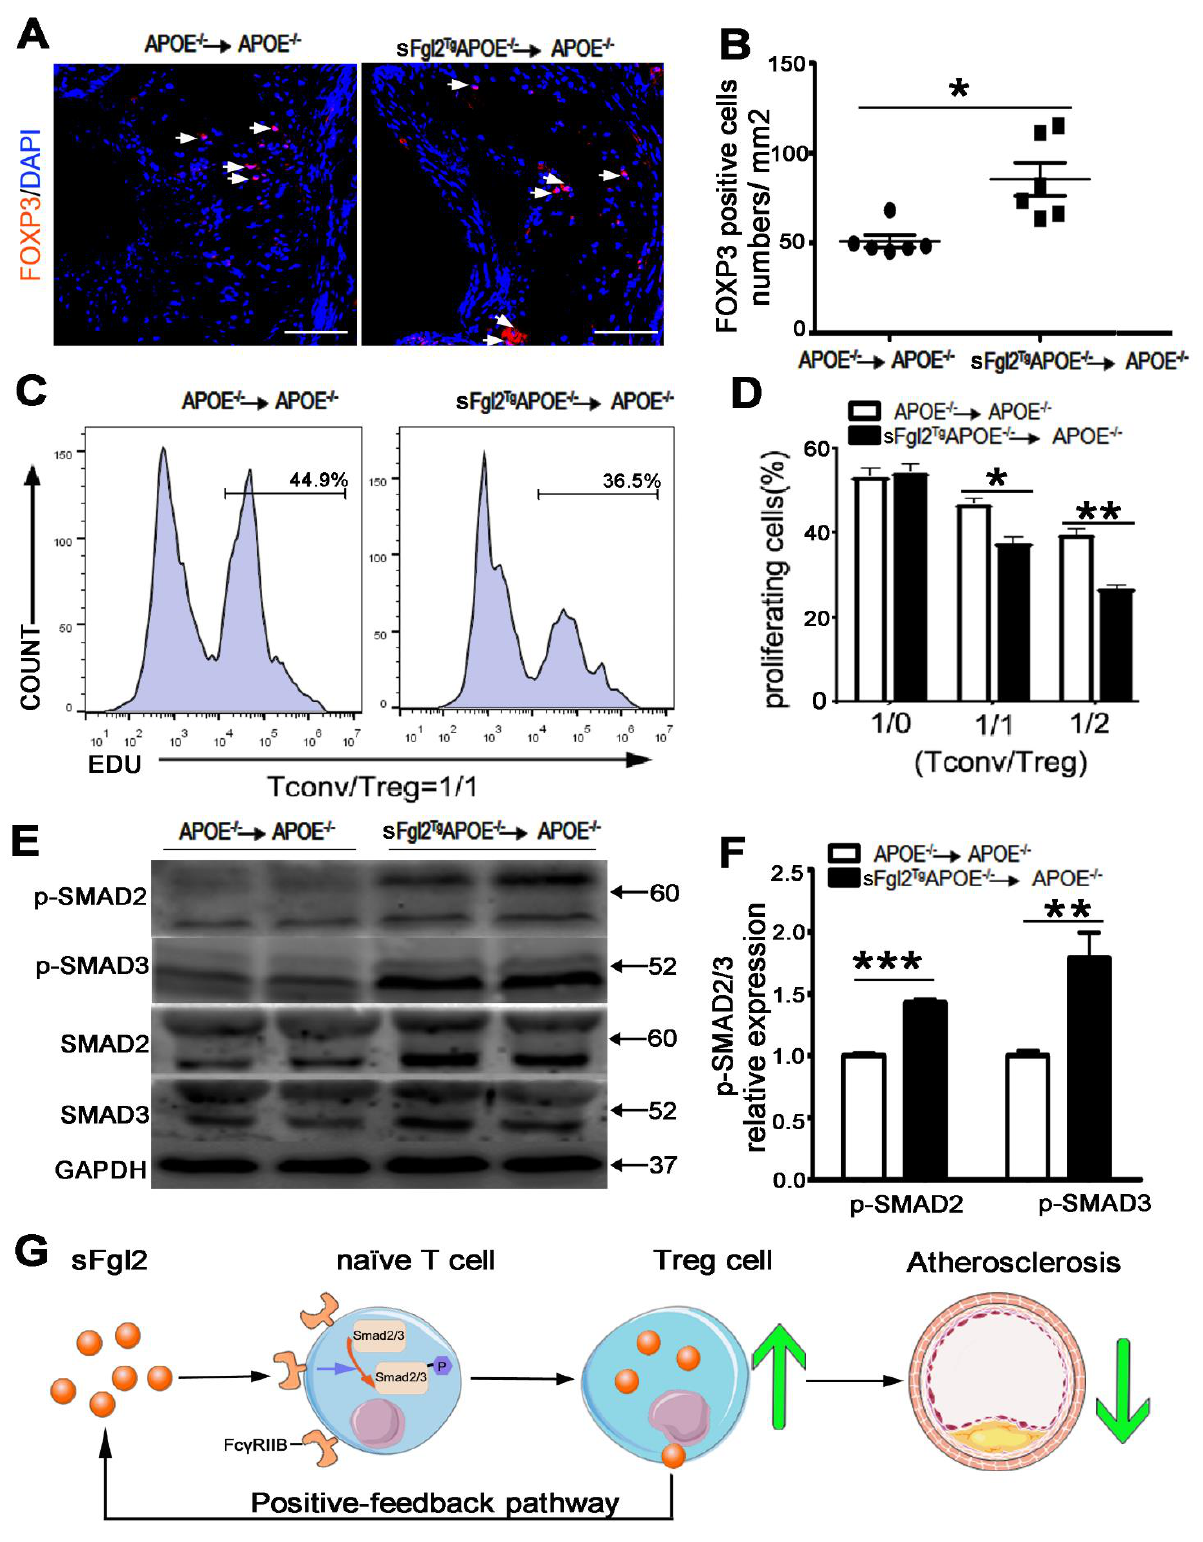
Figure 7. Bone marrow-derived sFgl2 increased the Tregs population and immunosuppressive function by binding to Fc γ RIIB receptors and phosphorylating Smad2/3. ( A ) Immunofluorescent staining and ( B ) quantification of Foxp3 in the aortic root cross-sections of the irradiated ApoE -/- mice reconstituted with sFgl2 Tg ApoE -/- or ApoE -/- bone marrow. Triangles indicate positive stained cells. Scale bar = 100 µ m. ( C ) Firstly, CD4+CD25- (T Conv ) cells from WT mice and CD4+CD25+